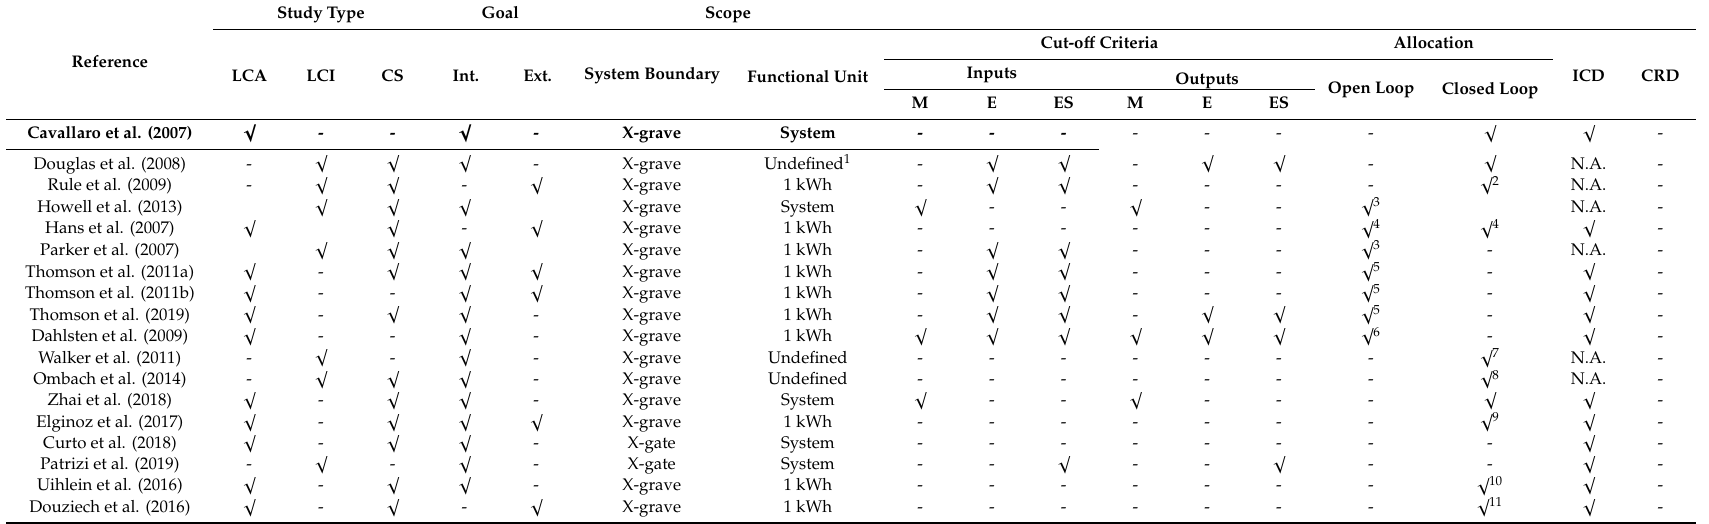
Table 2. Goal and scope definition of studied